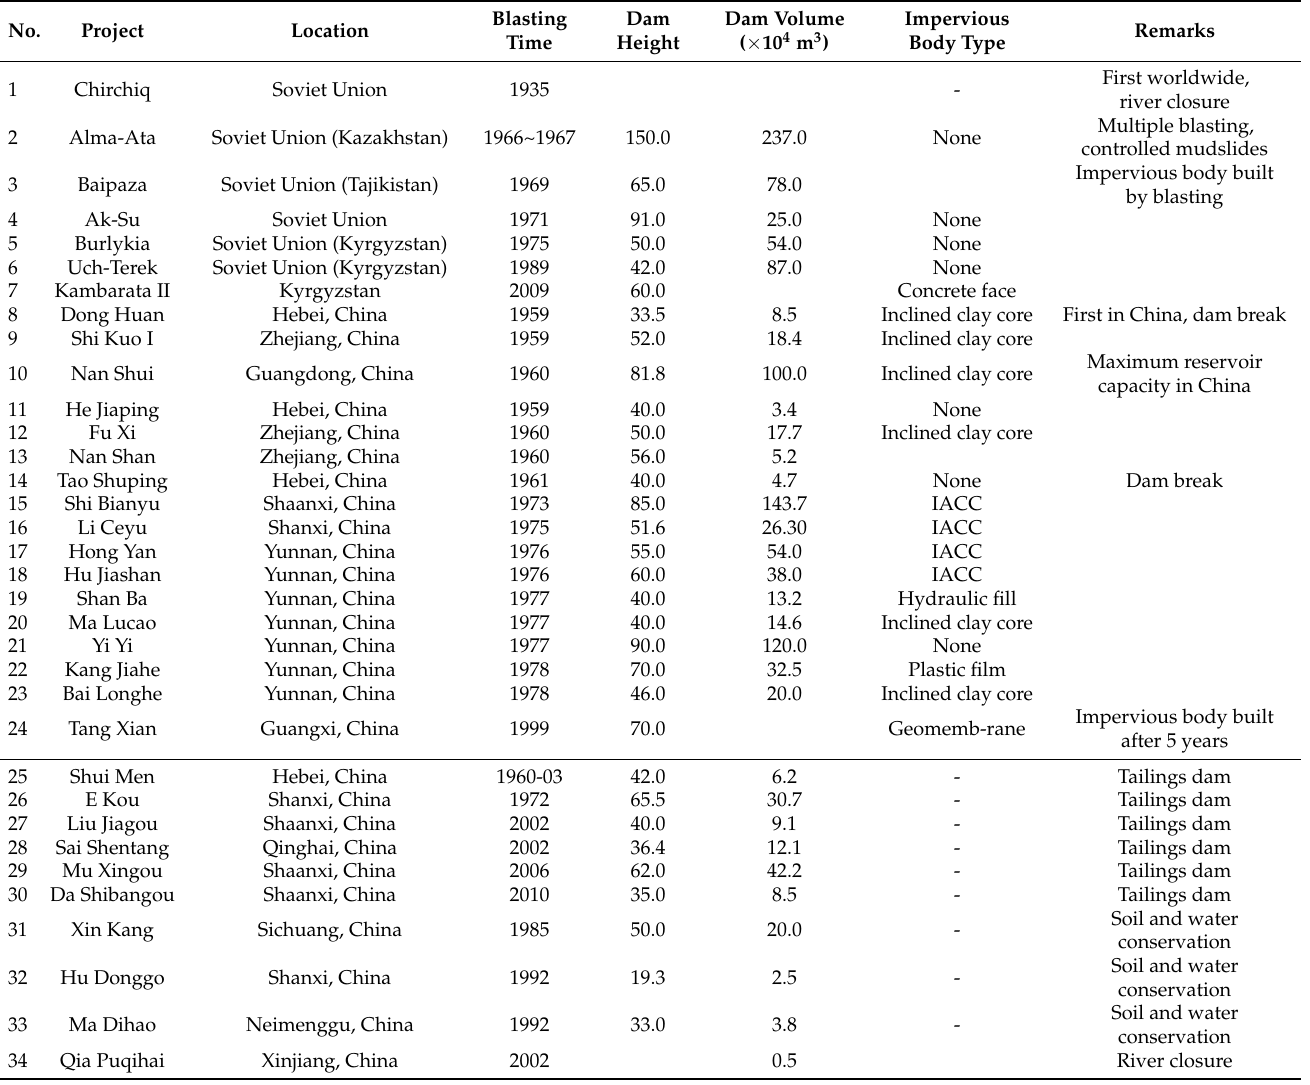
Table 1. Statistics on the main blast-fill